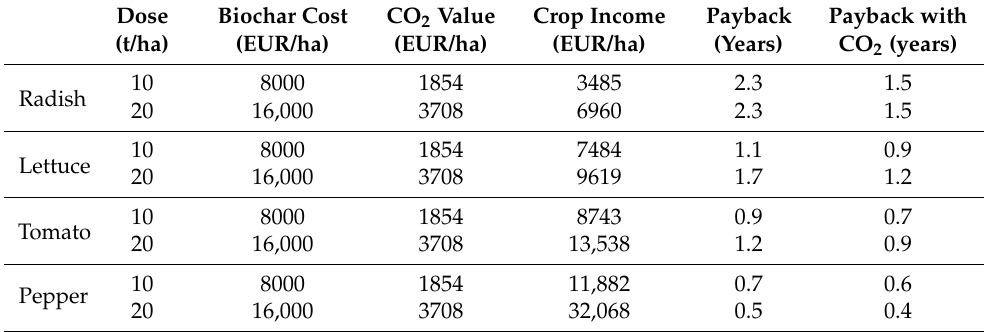
Table 8. Calculation of the period of recovery of the investment and contribution of the price of CO 2